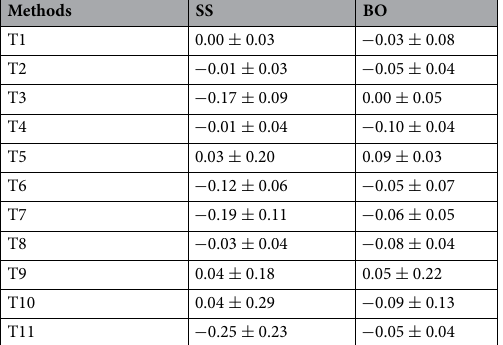
Table 3. Accuracy and precision of the developed and adopted methods in detecting 184 Skate strikes (SS) and 185 Blades offs (BO). The results are expressed as mean and standard deviations (SD) of the errors (in second, across participants) obtained by all methods described in Table 1 for detected temporal events using IMUs against those obtained using pressure insoles.